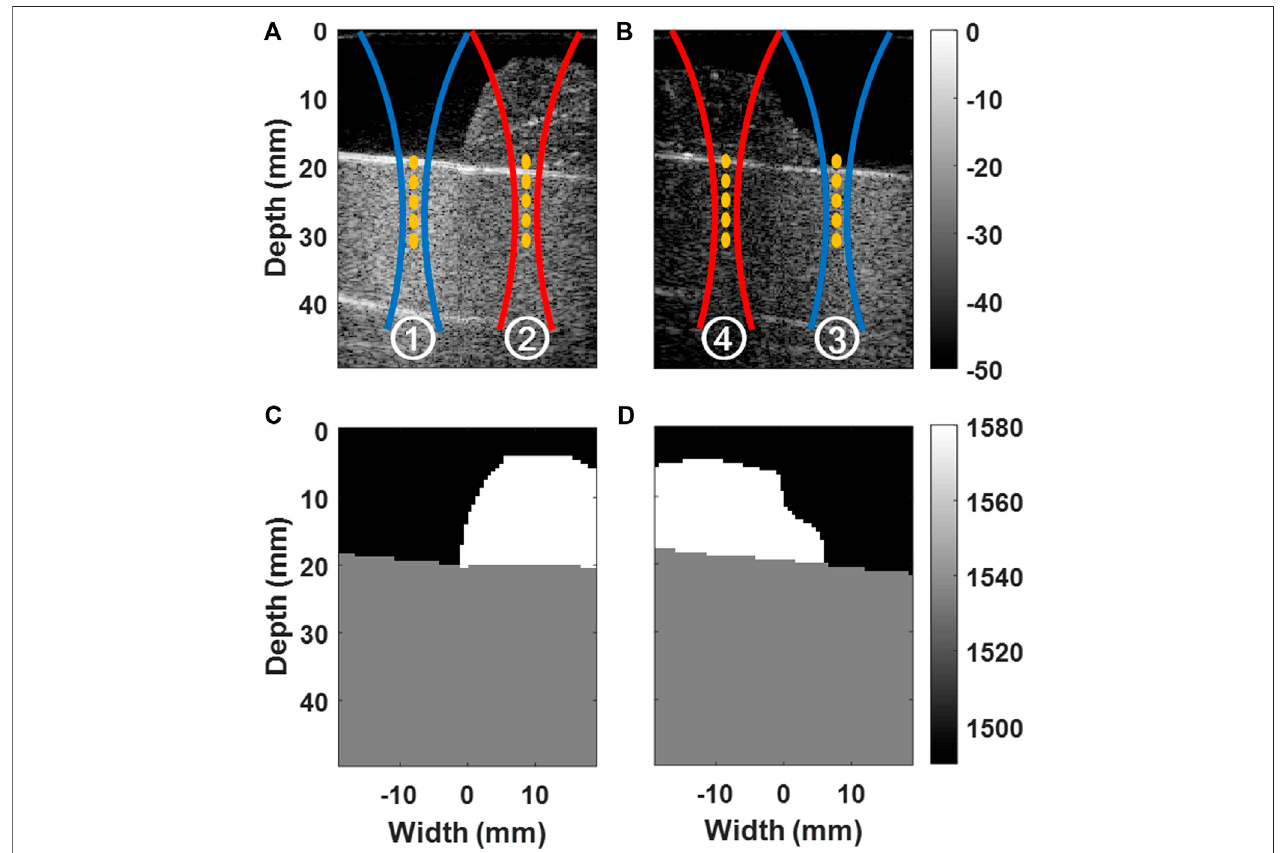
FIGURE 2 | Illustration of experimental con fi gurations. B-mode images of water and porcine muscle layers placed on CIRS phantom are shown in (A) for the experimental con fi gurations ① and ② , and in (B) for ③ and ④ . Acoustic radiation force push markings are overlaid. Manually-segmented custom SoS maps ( σ map ) are shown in (C) for ① and ② , and in (D) for ③ and ④